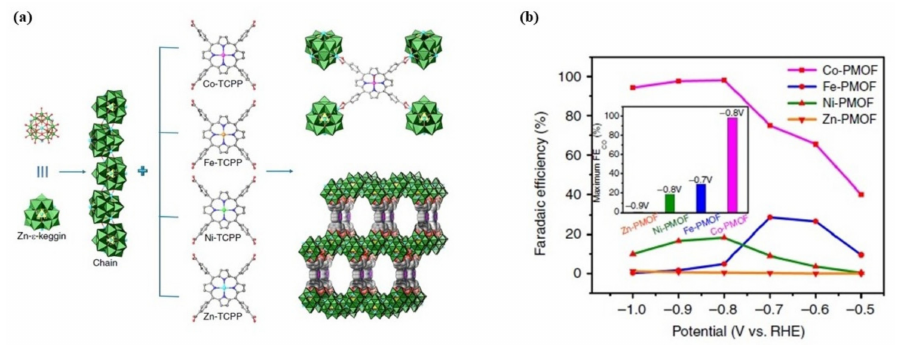
Figure 24. ( a ) Schematic of the structures of M-PMOFs (M = Co, Fe, Ni, Zn), ( b ) Faradaic efficiencies of M-PMOFs for CO